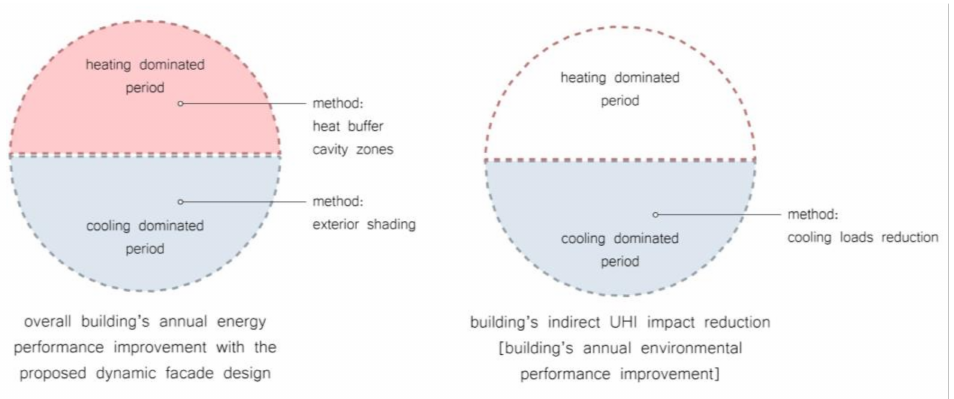
Figure 28. Charts summarizing the indirect impact evaluation